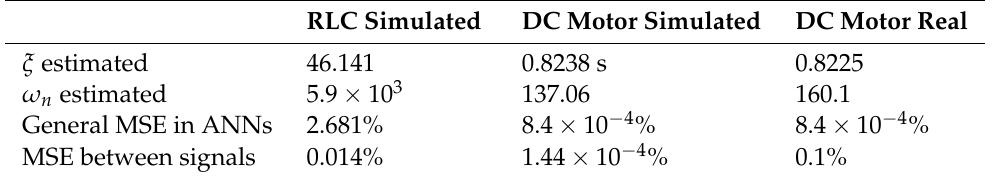
Table 8. Summary of the